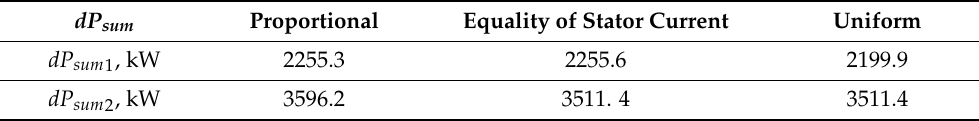
Table 3. Total active power losses observed at different values of Q sum : Q sum = 200 MVAr (d P sum 1 ) and Q sum = − 300 MVAr (d P sum 2 ).